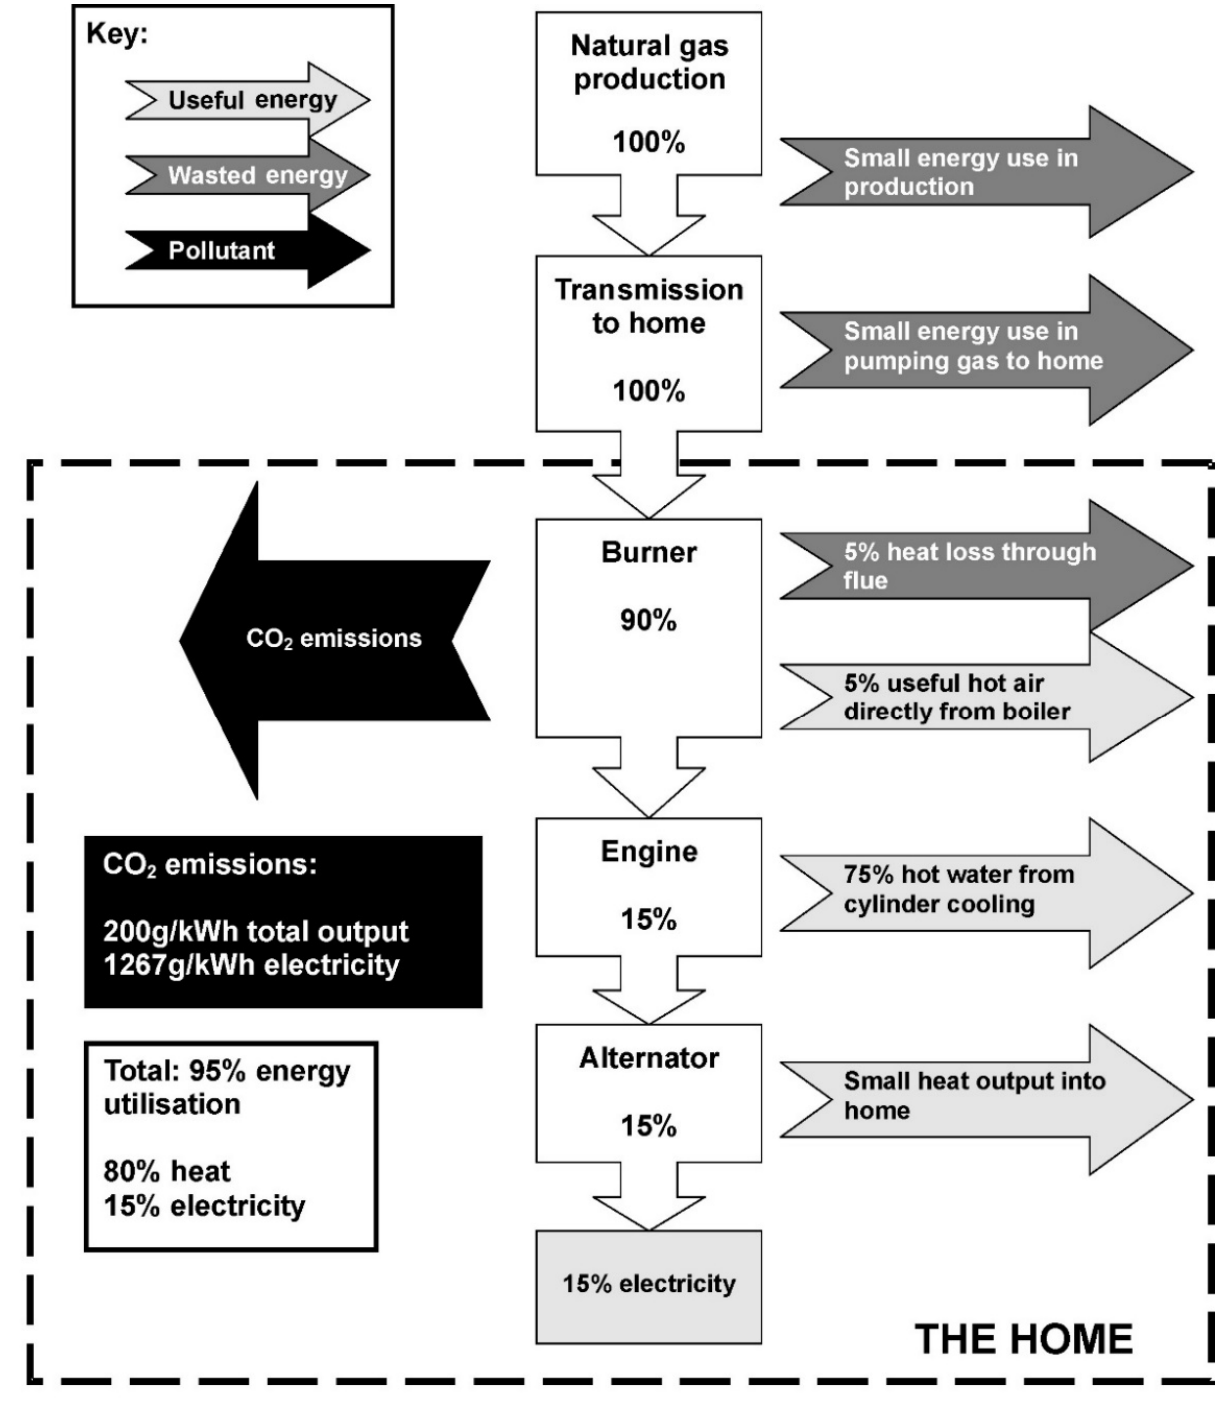
Figure 8. Indicative energy and emissions balances for a micro-CHP system based on a natural gas-fired Stirling engine on a ‘full fuel cycle’ basis.